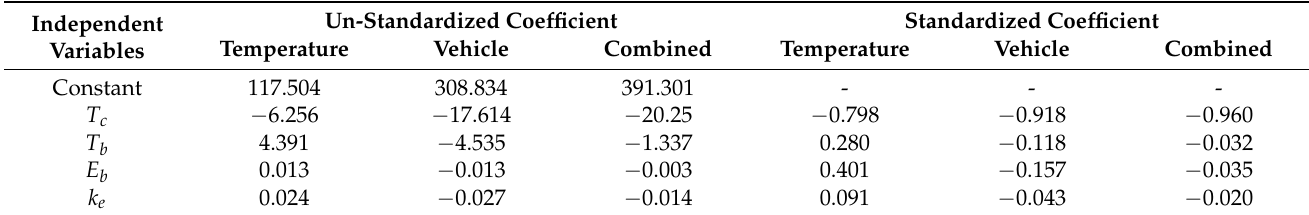
Table 12. Regression coefficients for the maximum stress under temperature, vehicle wheel, and combined loading con- ditions.